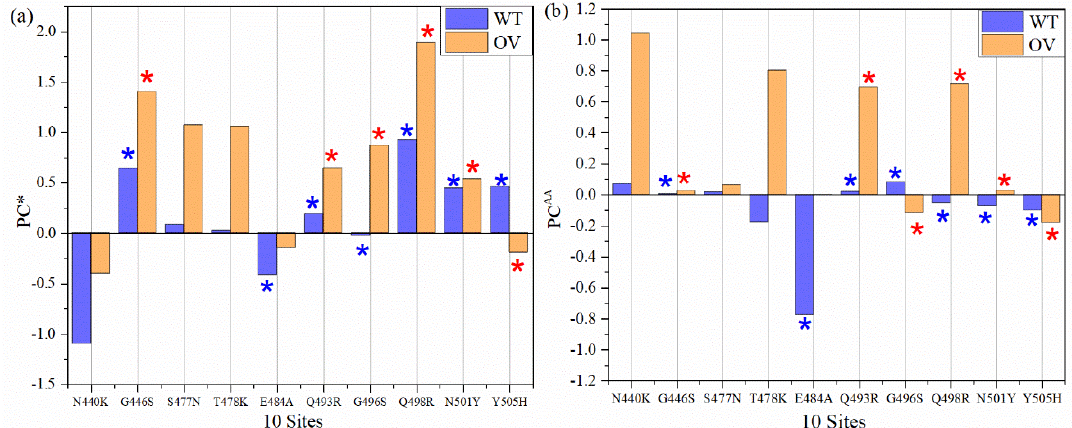
Figure 5. Partial charge (PC) for 10 sites before and after mutation: ( a ) PC per AABPU (PC*) for 10 sites ( b ) PC for each AA (PC AA ). One out of ten mutated AABPU (Y505H) flips from positive PC* to negative PC* in relatively small amount. The PC* for mutation Q498R AABPU more than doubled. Two out of ten AAs (G496S and Y505H) PC AA value increase in the negative direction. The blue and red (*) signs denote AAs in WT and OV, respectively, that interact with ACE2.